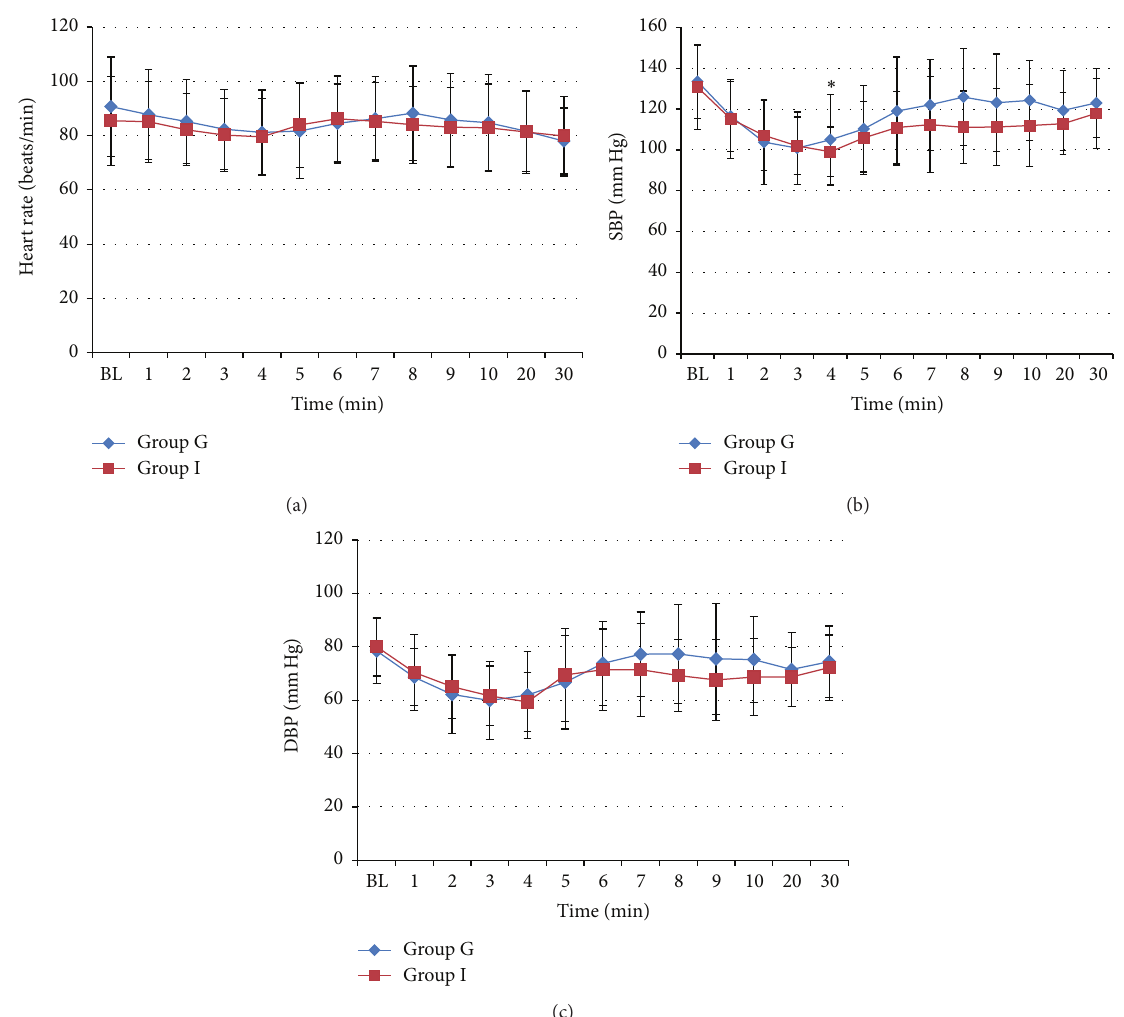
Figure2:(a)Heartratevariationbetweentwogroups.(b)Systolicbloodpressurevariationbetweentwogroups. ∗ 𝑝 = 0.04 ,repeatedmeasures ANOVA test. (c) Diastolic blood pressure variation between two groups.